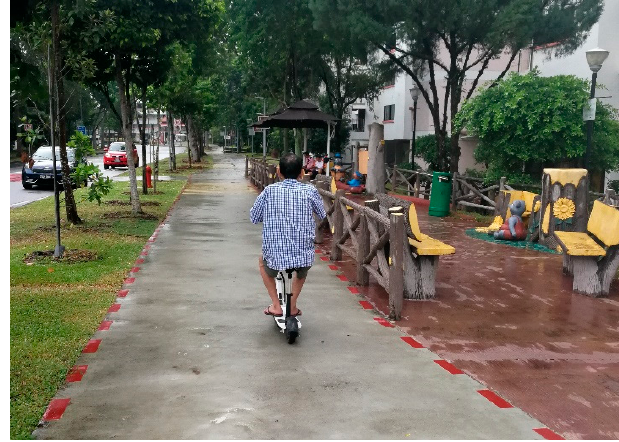
Figure 10. Pedestrians share the same sidewalk with those on an e-scooter.